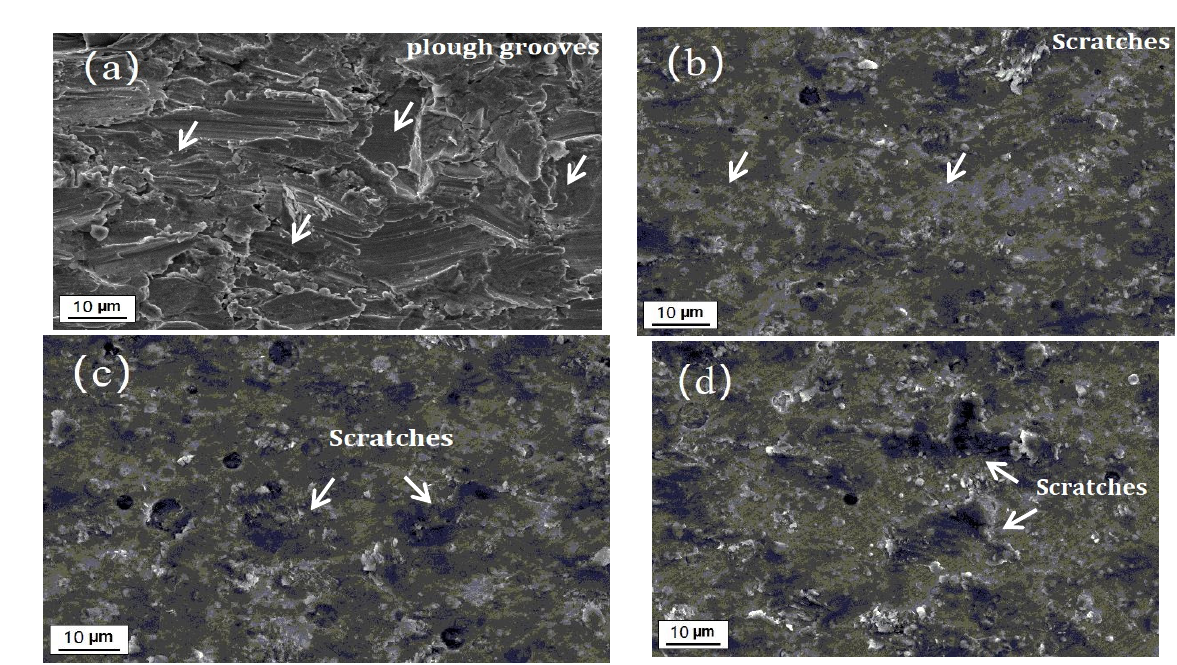
Figure 11. SEM surface micrographs of samples after slurry erosion-corrosion tests. ( a ) AISI 420, ( b ) Coating #1 single layer, ( c ) Coating #2 multilayer, ( d ) Coating #3 gradient layer.